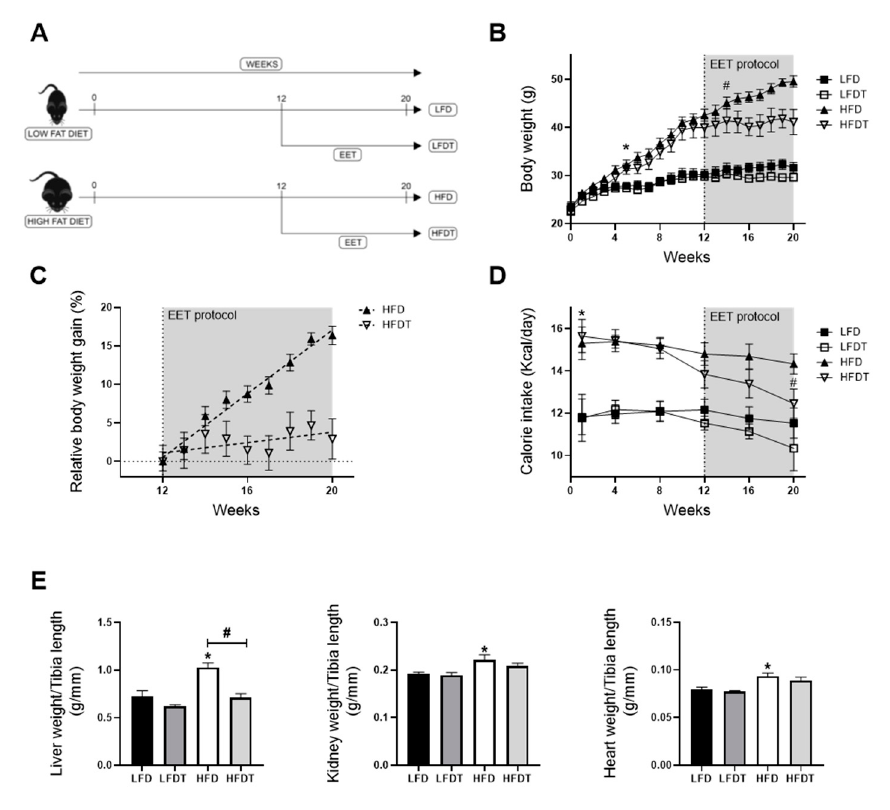
Figure 1. Delayed endurance exercise training (EET) prevents body weight gain and organ hypertrophy induced by HFD in mice. ( A ) Schematic representation of experimental design. Obesity in mice was induced with 12 weeks on a high-fat diet (HFD). Control mice were fed with a low-fat diet (LFD). Mice were subsequently divided in sedentary or trained groups on a treadmill for eight additional weeks (LFD, LFDT, HFD, HFDT). ( B ) Body weight evolution throughout the experimental protocol (20 weeks). Statistical analyses were performed by two-way ANOVA followed by Newman–Keuls post hoc test. ( C ) Relative body weight gain in HFD vs. HFDT mice during EET protocol normalized with body weight at week 12. The slope was determined with simple linear regression analysis. n = 10 in each group. ( D ) Calorie intake evolution throughout the experimental protocol. Number of calories consumed per day calculated for each mouse at different time-point (at week 1, 4, 8, 12, 16 and 20 of the experimental protocol). Statistical analyses were performed by two-way ANOVA followed by Newman–Keuls post hoc test. ( E ) Organ weights at week 20. Statistical analyses were performed by one-way ANOVA followed by Newman–Keuls post hoc test. Data are presented as means ± SEM. * p ≤ 0.05 versus LFD # p ≤ 0.05 versus HFD. n = 10 in each